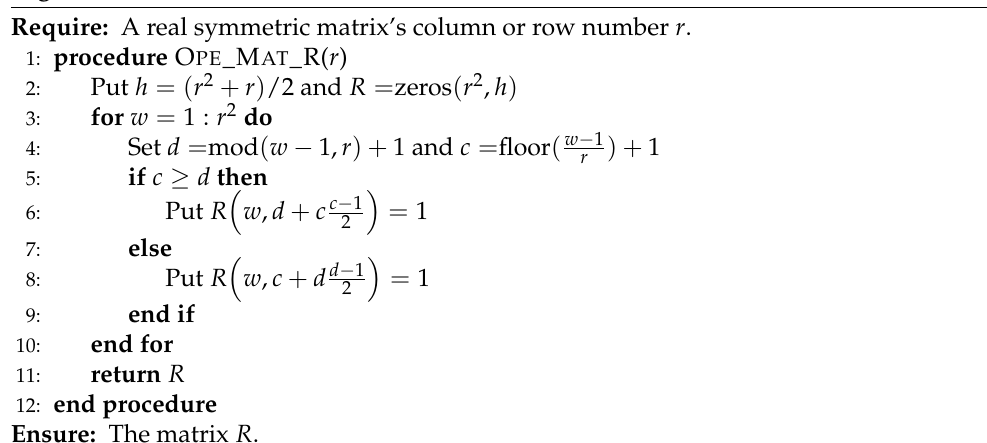
Algorithm 3 Matrix R